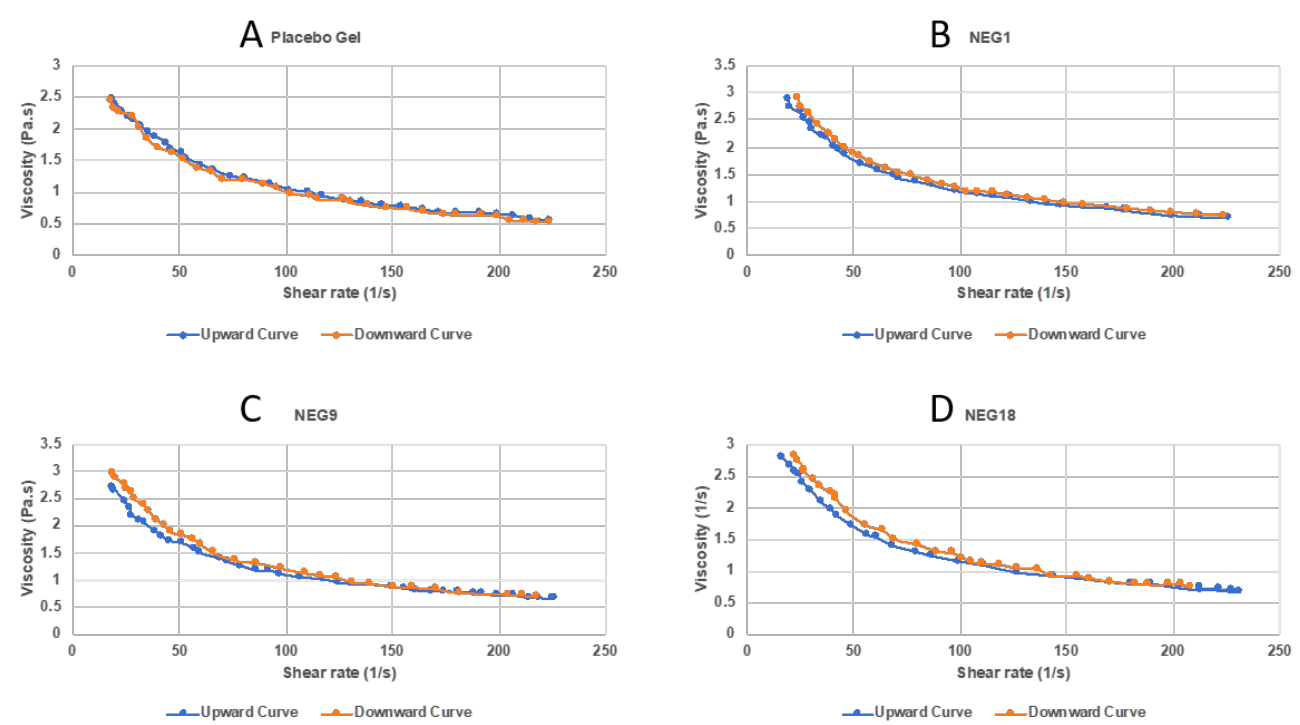
Gels 2022 , 8 , x FOR PEER REVIEW Figure 5. Rheology profile of ( A ) Placebo gel, ( B ) TAM-NEG1, ( C ) TAM-NEG9, and ( D ) TAM-NEG18.